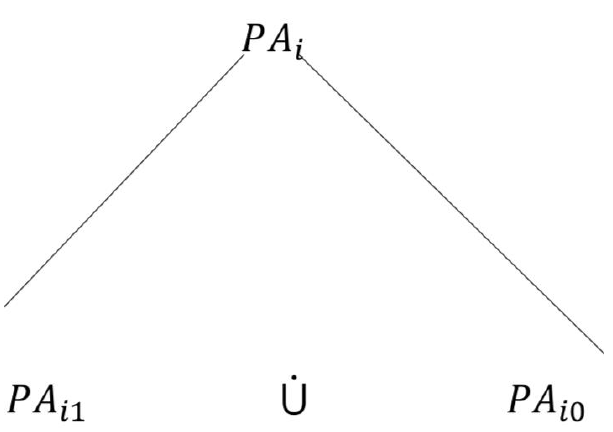
Figure 4. The global states of a 𝑷𝑨 𝒊 .